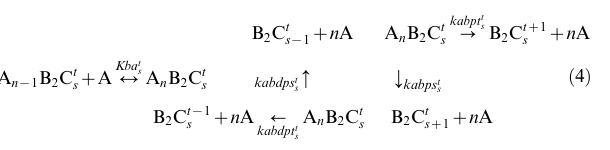
Figure 2. Circadian oscillations of Kai proteins in the full reaction network using deterministic method. (A) Circadian oscillation of fractional saturation of phosphates for S431 ( Y S , dashed line), T432 ( Y T , dotted line), and overall ( Y , solid line). We defined Y S ; g s , t s ([LC t s ] + [LBC t s ])/(6[C] T ), Y T ; g s , t t ([LC t s ] + [LBC t s ])/(6[C] T ) and Y ; g s , t ( s + t )([LC t s ] + [LBC t s ])/(12[C] T ), where [C] T is the total amount of KaiC hexamers. (B) The circadian profiles of m 01 (S431 phosphorylated only), m 10 (T432 phosphorylated only), m 11 (dual phosphorylated) and their total amount (m 01 + m 10 + m 11 ). (C) Oscillatory profiles of free KaiC